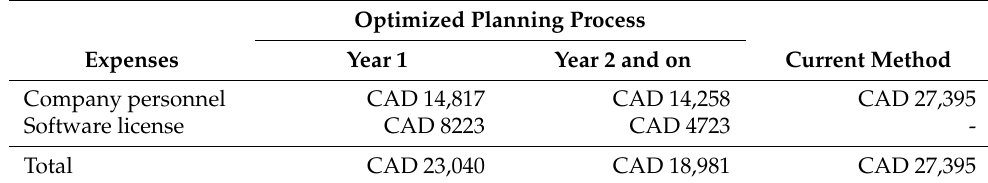
Table 3. Comparison between current planning costs and optimized planning costs for the first year of implementation and following years.